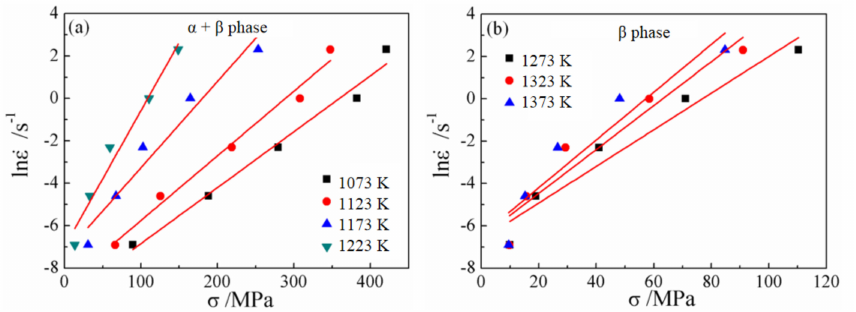
. ε and σ at a strain of 0.6 in different phase region: ( a ) α + β phase